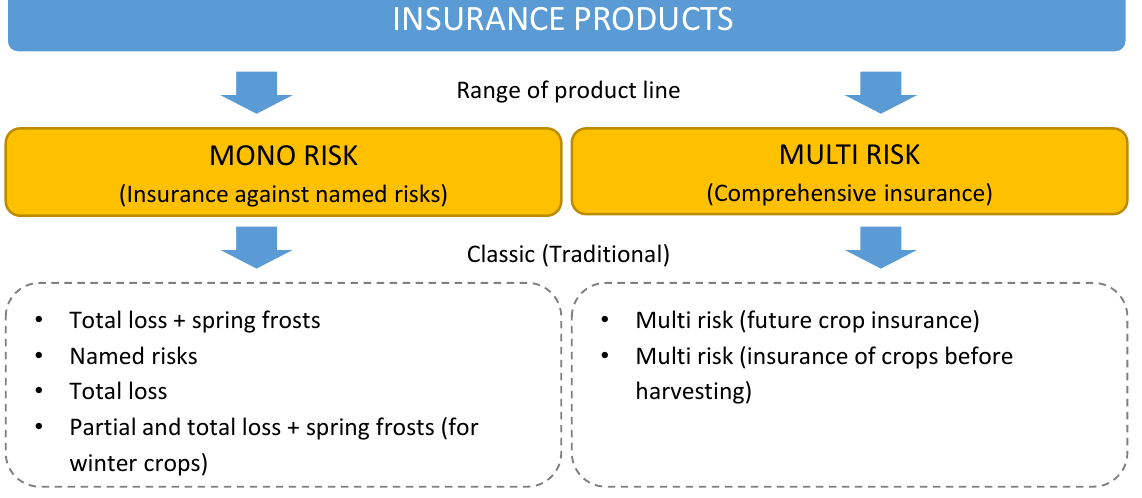
Figure 6. Types of insurance products